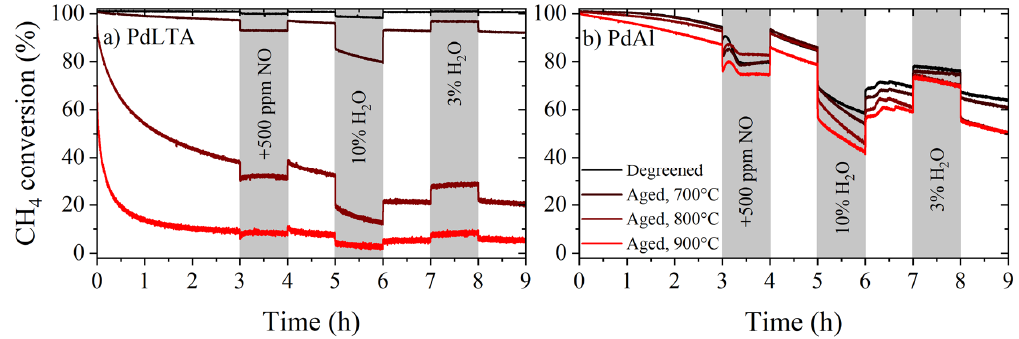
Figure 4. Isothermal CH 4 oxidation activity test at 450 ◦ C for ( a ) PdLTA and ( b ) PdAl that had been degreened or aged at 700, 800, or 900 ◦ C. White areas correspond to wet reaction mixture (500 ppm CH 4 , 8% O 2 , and 5% H 2 O). Grey areas represent wet reaction mixture modified according to the text in each grey box.